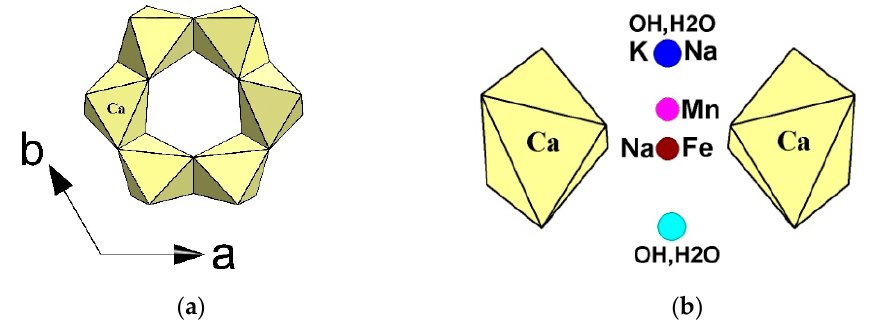
Figure 2. Six-membered ring composed of M 1 octahedra ( a ) and positions of some components in the M 2 micro-region between neighboring rings of M 1 octahedra ( b ).